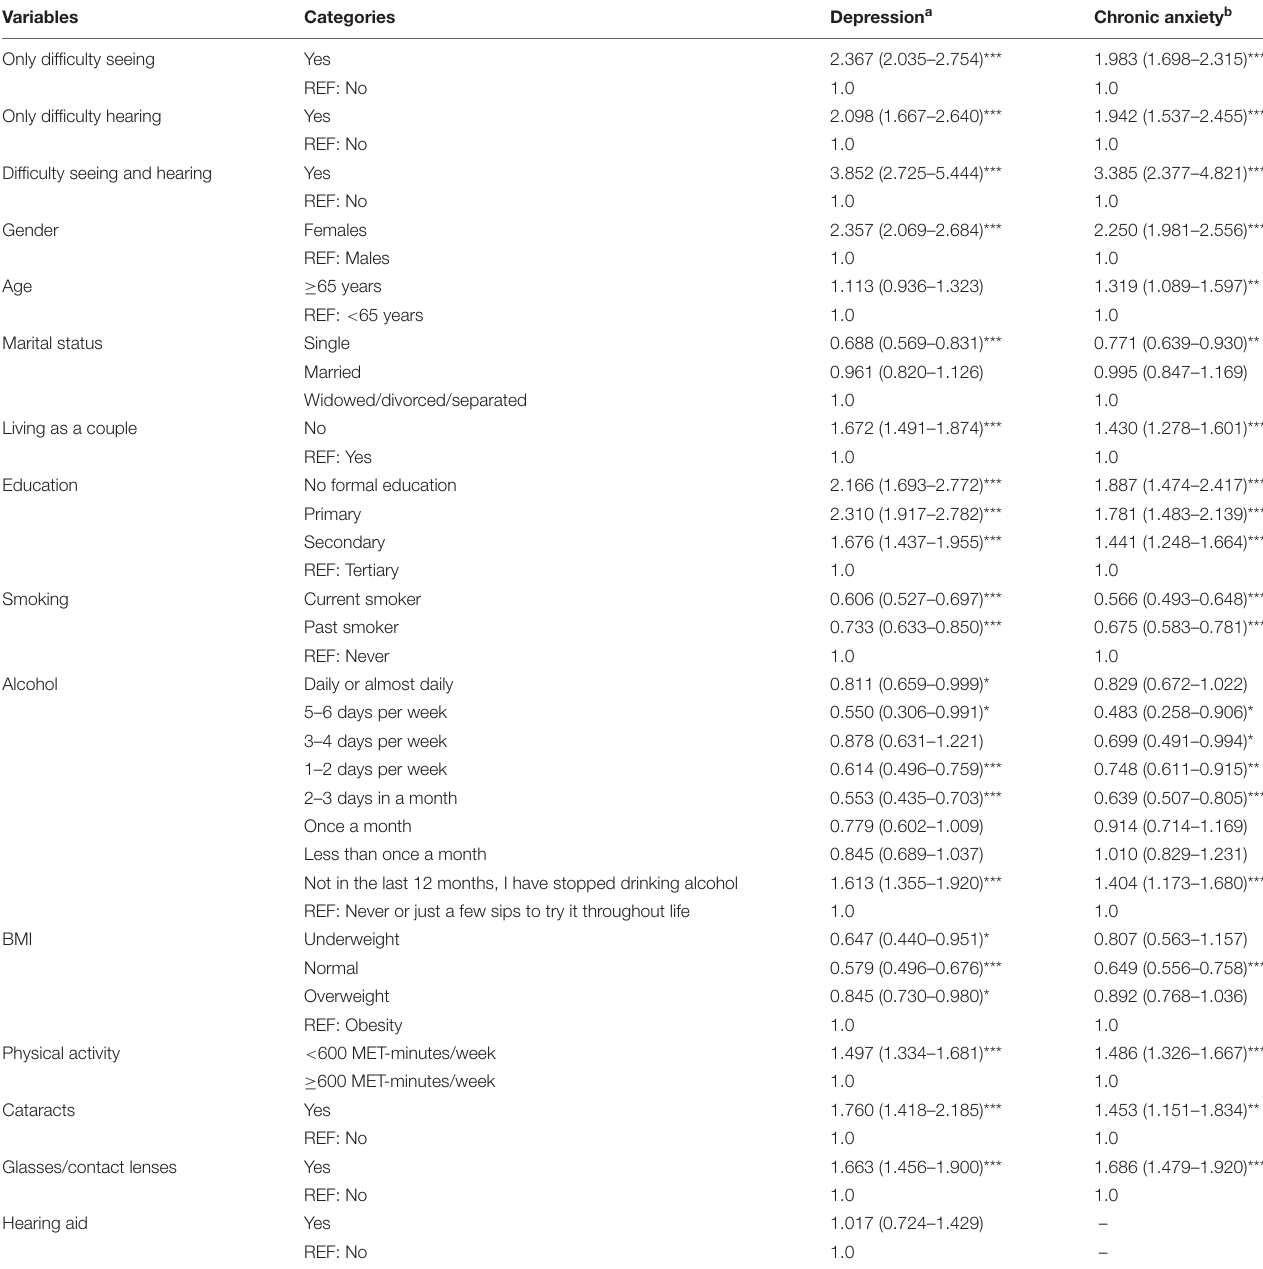
TABLE 2 | Associations between difficulties hearing and seeing (exposures) and other covariates with chronic anxiety and depression (outcomes) in Spanish adults, estimated by multivariable logistic regression.